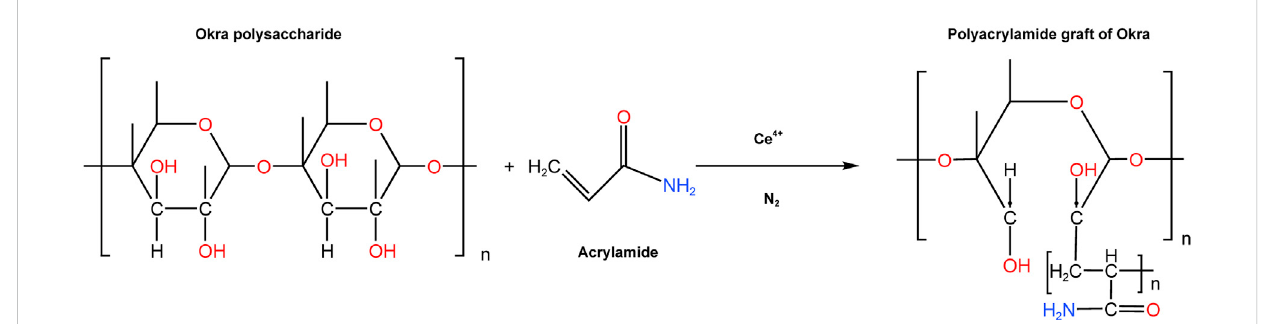
FIGURE 1 Mechanism for the synthesis of polyacrylamide-okra graft (Banerjee et al., 2012; Geethanjali et al.,